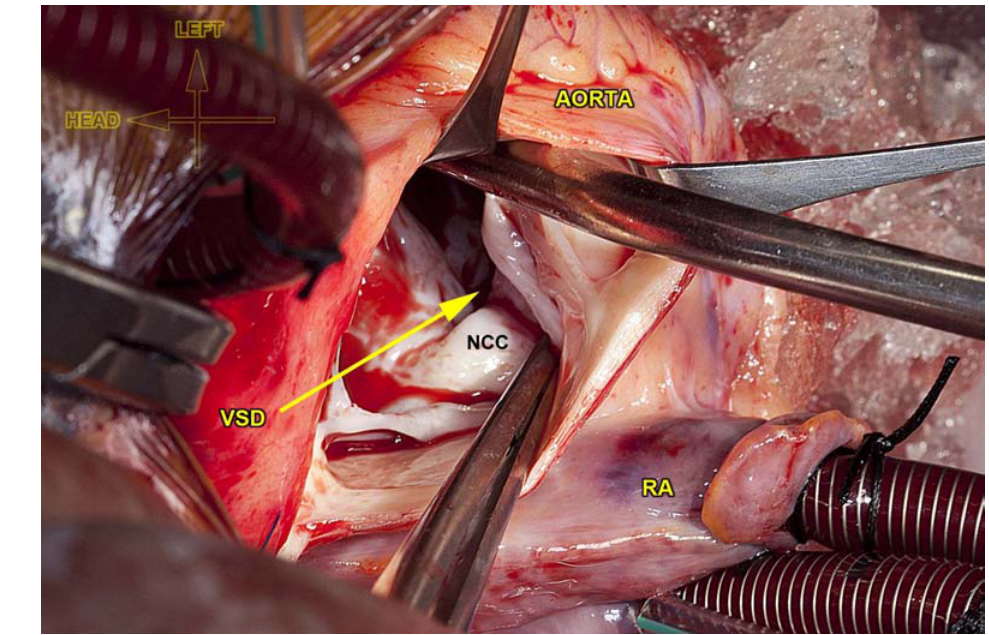
Figure 3. Operative photograph showing the non coronary cusp (NCC) retracted with a forceps revealing the ventricular septal defect (VSD) underneath it. RA (right atrium)